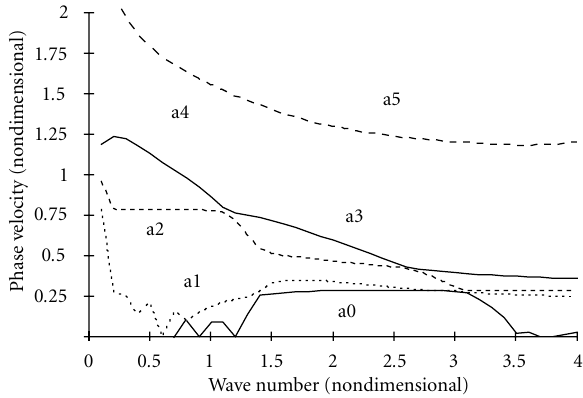
Figure 8.3. Dispersion of the first six flexural modes for τ 0 = 2 . 10 − 7 second and τ 1 = 1 . 10 − 6 second.